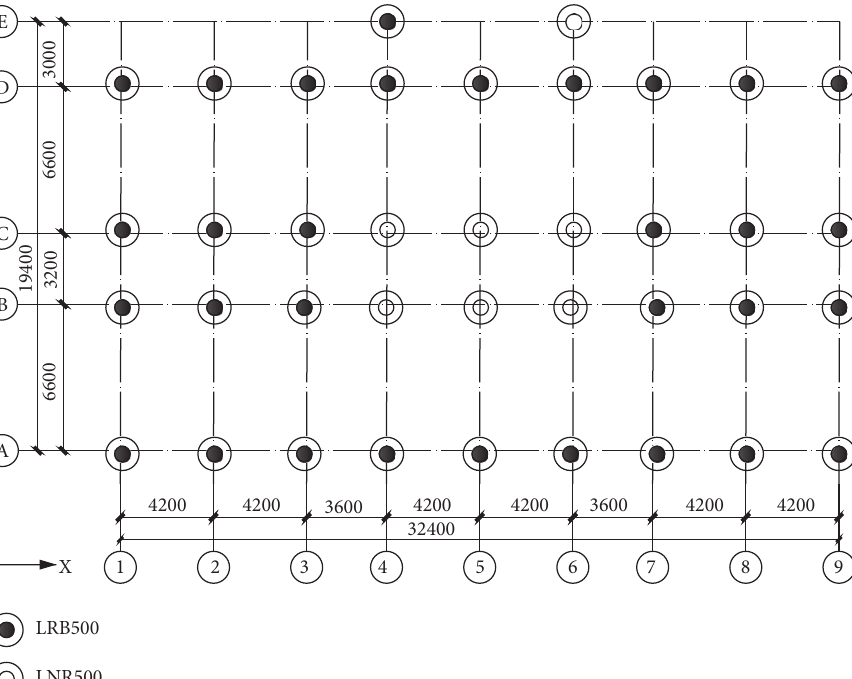
Figure 6: Original layout of the isolated layer.